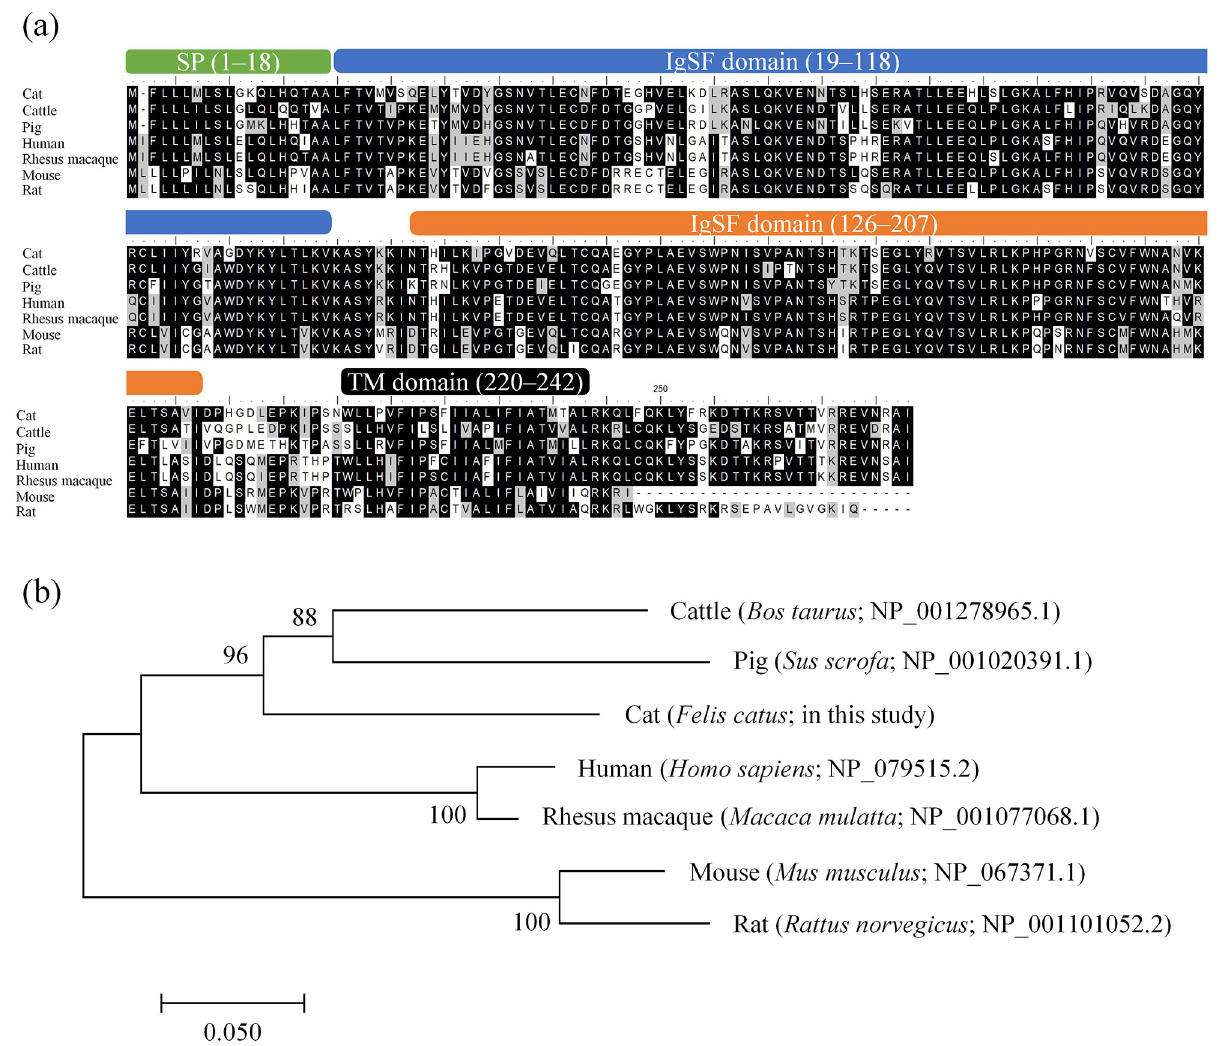
Fig 2. Identification of feline PD-L2 mRNA sequence. (a) Multiple sequence alignment of PD-L2 amino acid sequences in various mammalian species. The SP, IgSF domains, and TM domain are indicated with numbers representing the positions of amino acid residues. (b) Phylogenetic tree (inferred as described in Fig 1) of the feline PD-L2 amino acid sequence in relation to those of other mammalian species. Numbers next to the branches indicate the bootstrap percentage. The scale bar indicates the divergence time.